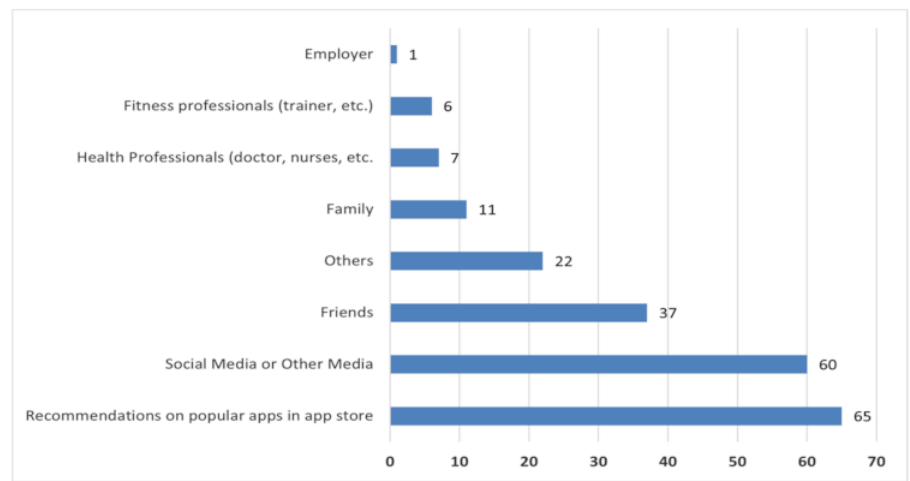
Figure 2. Positive drivers for engaging with mHealth apps.